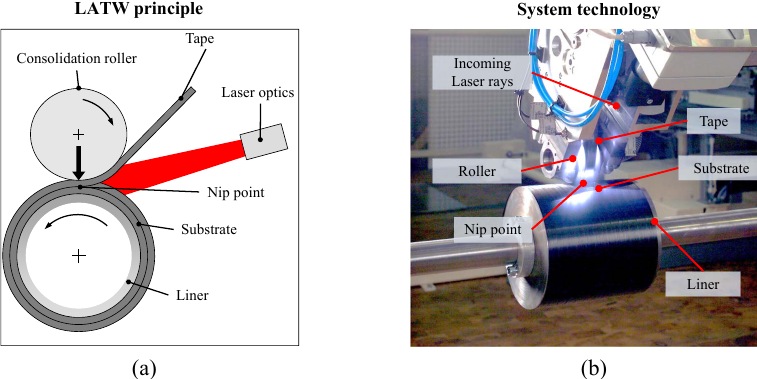
Figure 1. Description of the laser assisted tape placement or winding (LATP/LATW) method and its elements including laser optics, substrate, tape, roller and mandrel. The hoop winding/placement process where thermoplastic tape and substrate are preheated by the laser source and the tape is pressed on the substrate at the nip point location through a consolidation roller are shown as: ( a ) Principle, ( b ) System technology (detailed view on the experimental set-up employed at Fraunhofer IPT, Aachen,